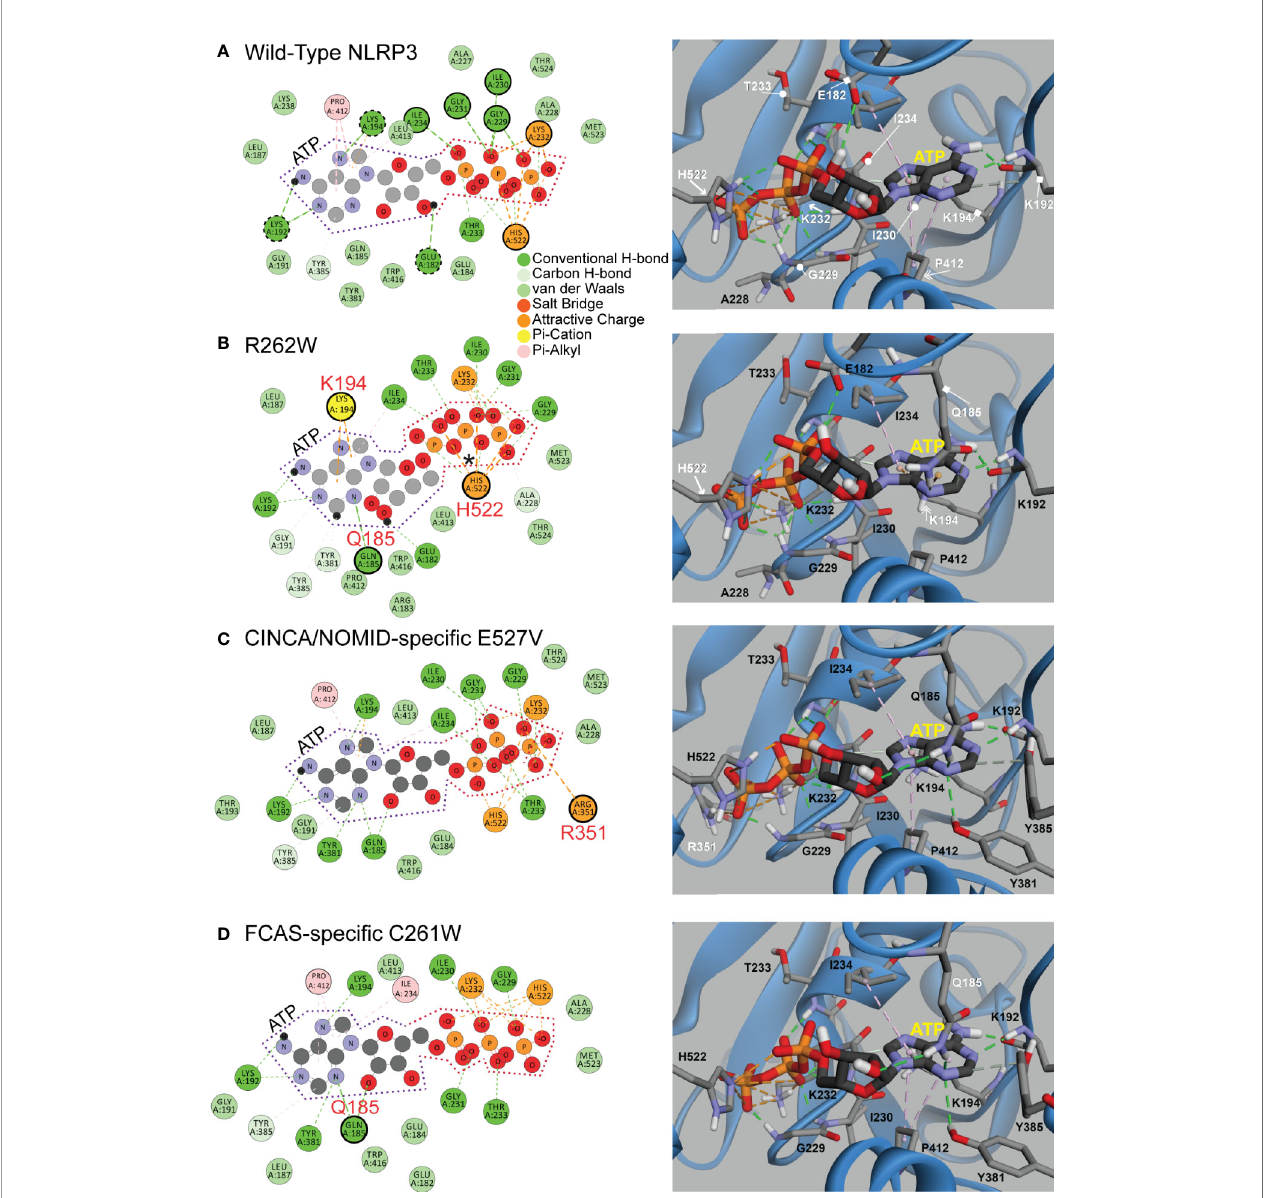
FIGURE 4 | 2D and 3D Interaction Plots of Mutations Affecting ATP Binding. (A, B) 2D and 3D Interaction Plots of wild-type) (WT) NLRP3 and the R262W mutant. (C, D) 2D and 3D interaction plots of chronic infantile neurologic cutaneous and articular syndrome, also known as neonatal-onset multisystem in fl ammatory disease (CINCA/NOMID)- speci fi c E527V mutant and familial cold autoin fl ammatory syndrome (FCAS)-speci fi c C261W mutant. ATP is demarcated by purple and orange dotted lines in the 2D panel (left panels). In the 3D panels (right panels), ATP is shown in a stick model with the yellow label, while NLRP3 is shown as a ribbon